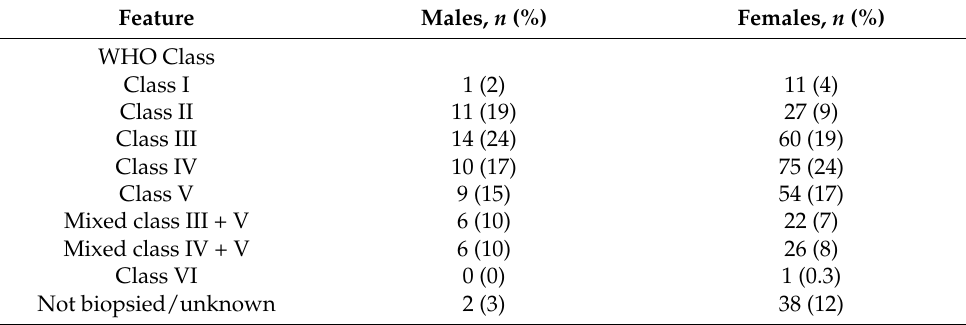
Table 2. WHO class in n = 59 males and n = 314 females with cSLE and lupus nephritis